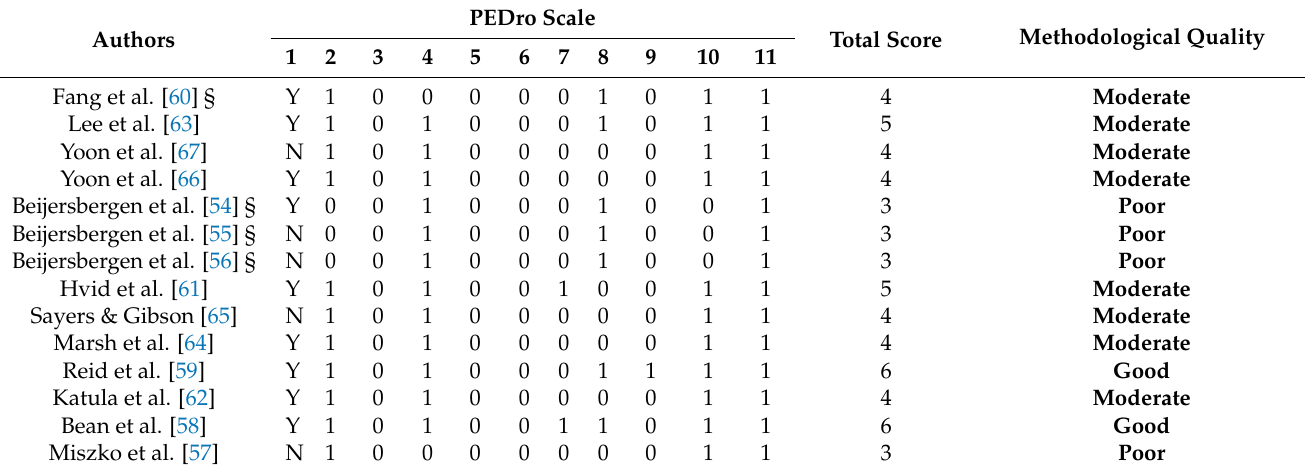
Table 1. Analysis of the risk of bias of the studies included in this systematic